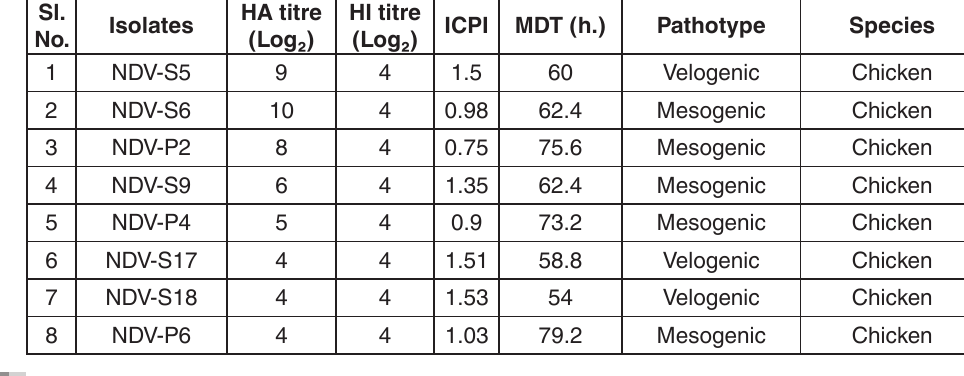
table 2. HA, HI titre and pathogenicity indicies of NDV isolates sl.